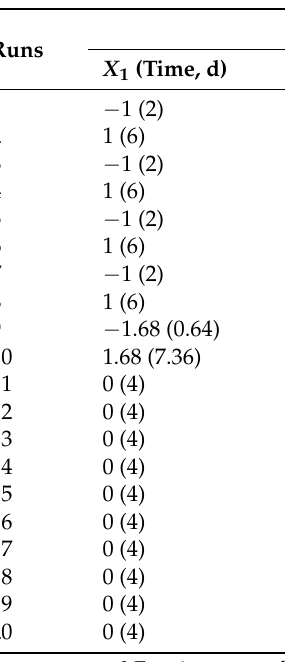
Table 1. Results of the central composite design for the laccase